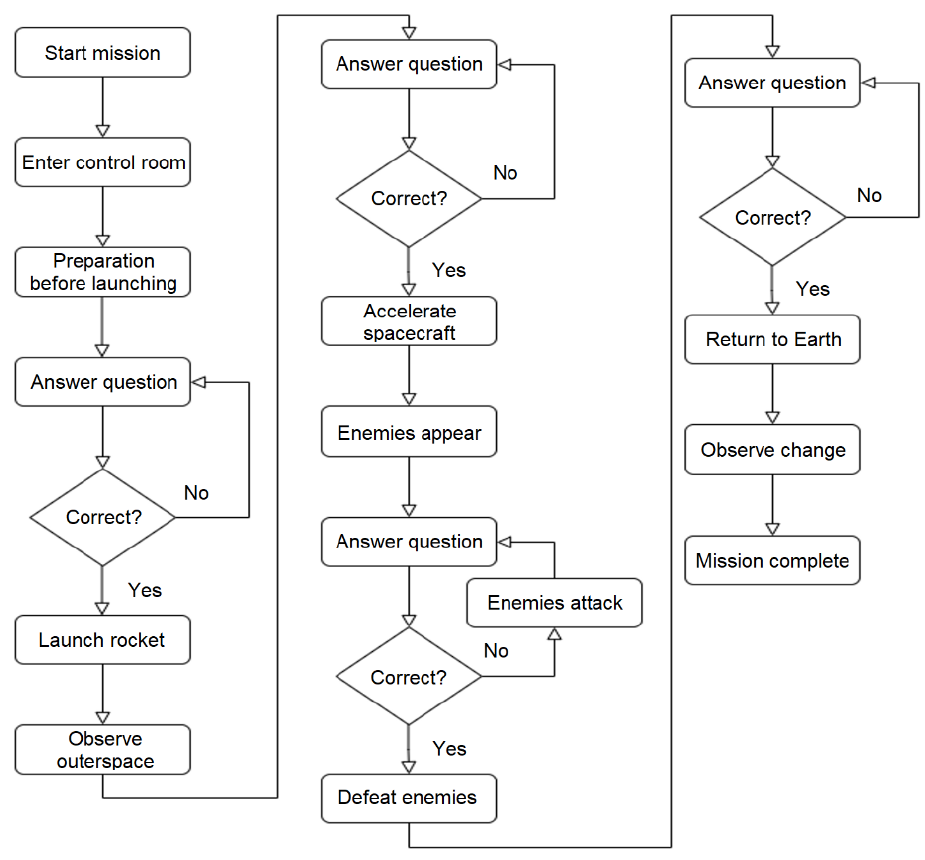
Figure 6. Flowchart of the VR system operation.